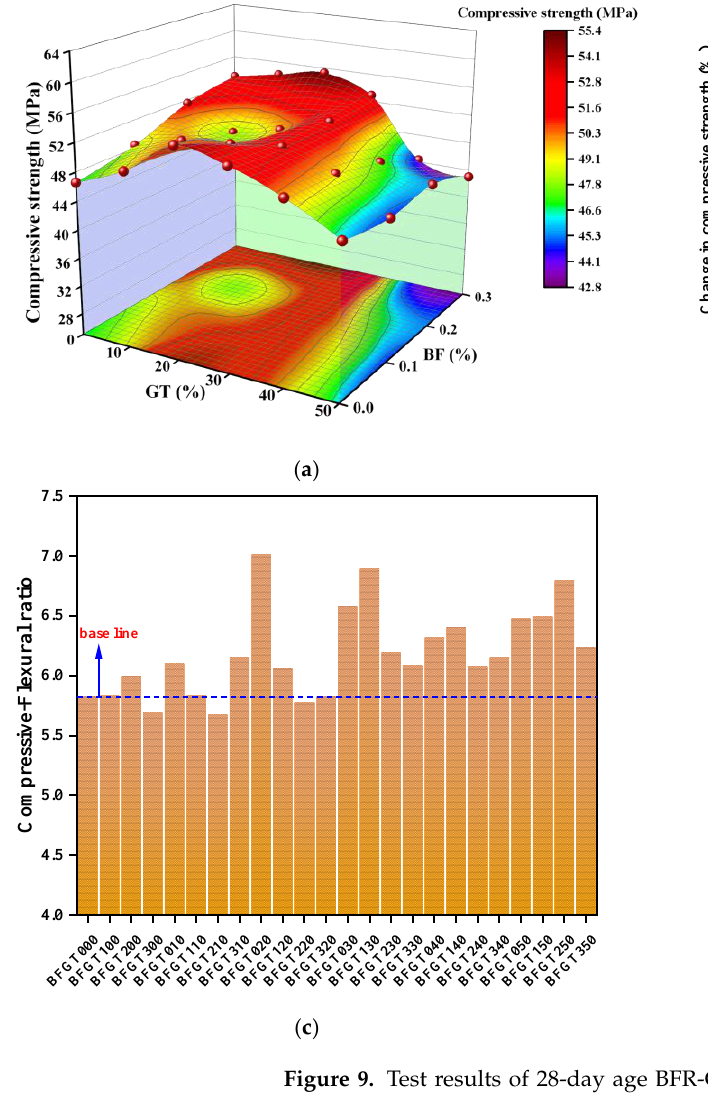
Figure 9. Test results of 28-day age BFR-GTCM compressive strength: ( a ) compressive strength at 28 days of age; ( b ) change in compressive strength at 28 days of age (based on BFGT000); ( c ) compression-flexural ratio of BFR-GTCM at 28 days of age.